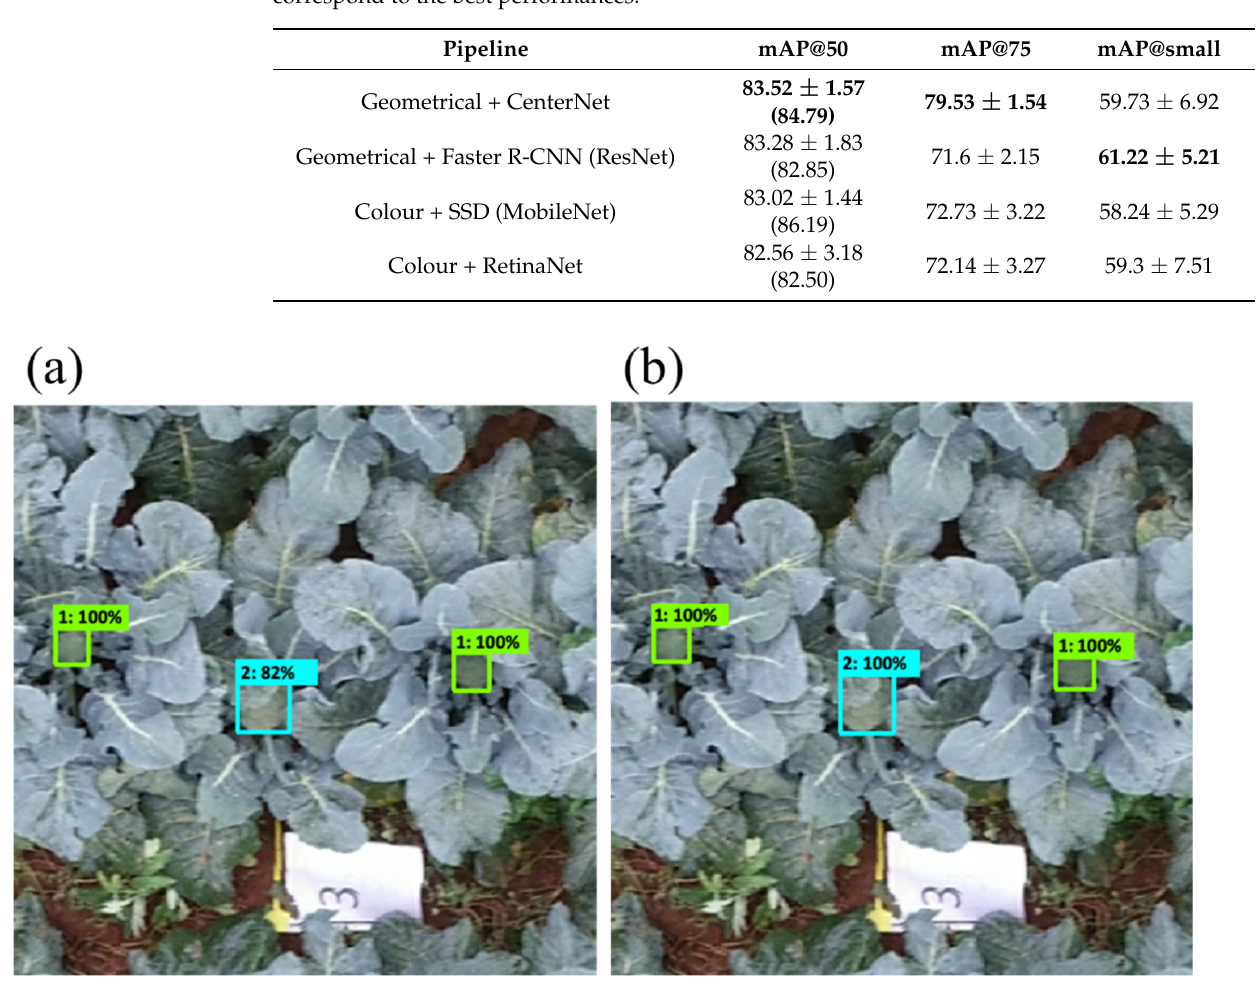
Table 8. The performance of the selected architectures and augmentation types on the two-class dataset. In the parentheses, the training performance is presented for mAP@50. The bold numbers correspond to the best performances.